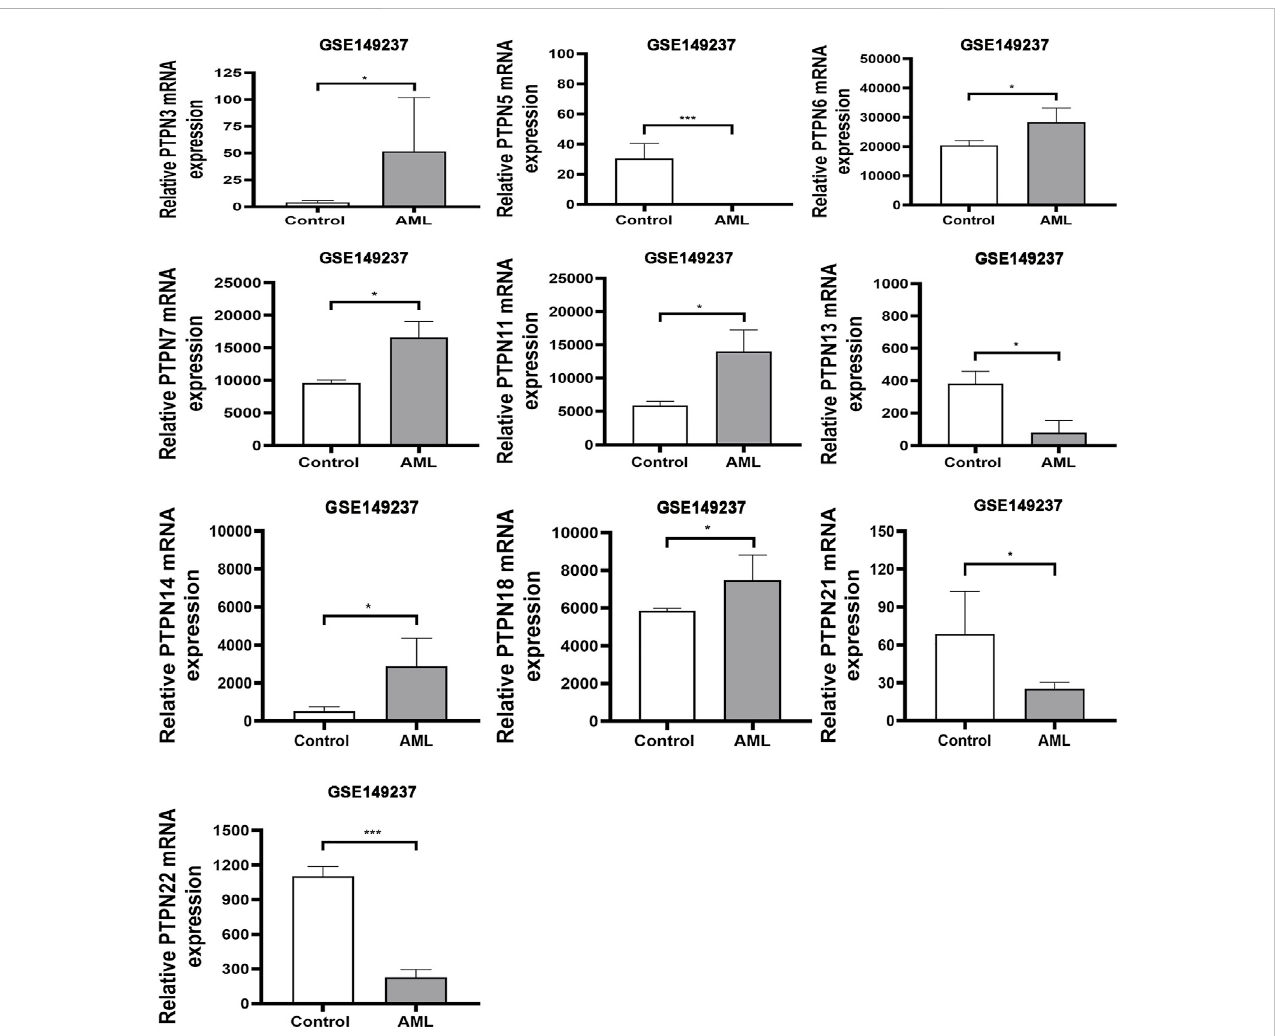
FIGURE 1 In theGSE149237 microarray dataset, there weredifferential transcript levels of the PTPN gene in AML and healthy control samples. The fi lter conditions are p -value < 0.05 and the absolute value of the difference (| log2 (Fold Change) |) >